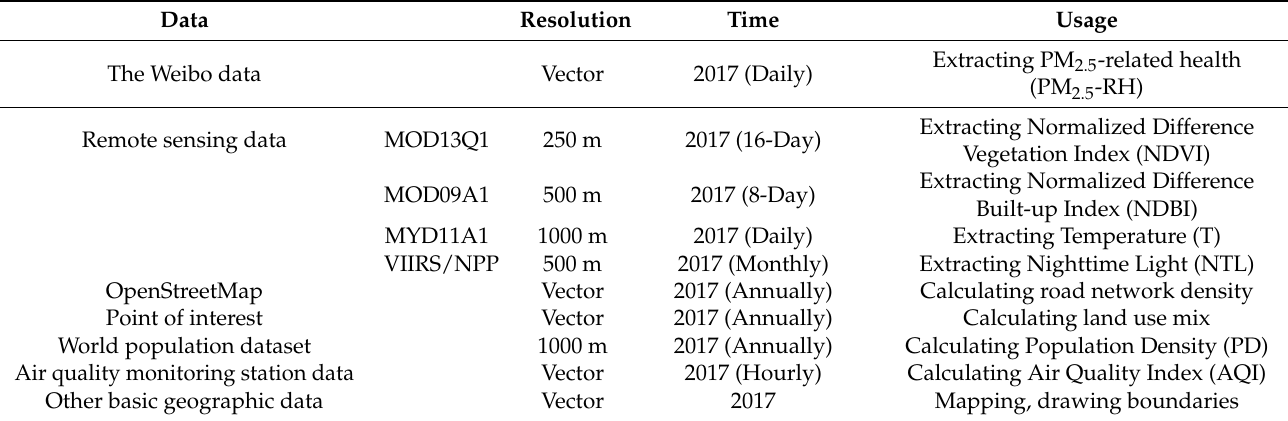
Table 1. Data used in this